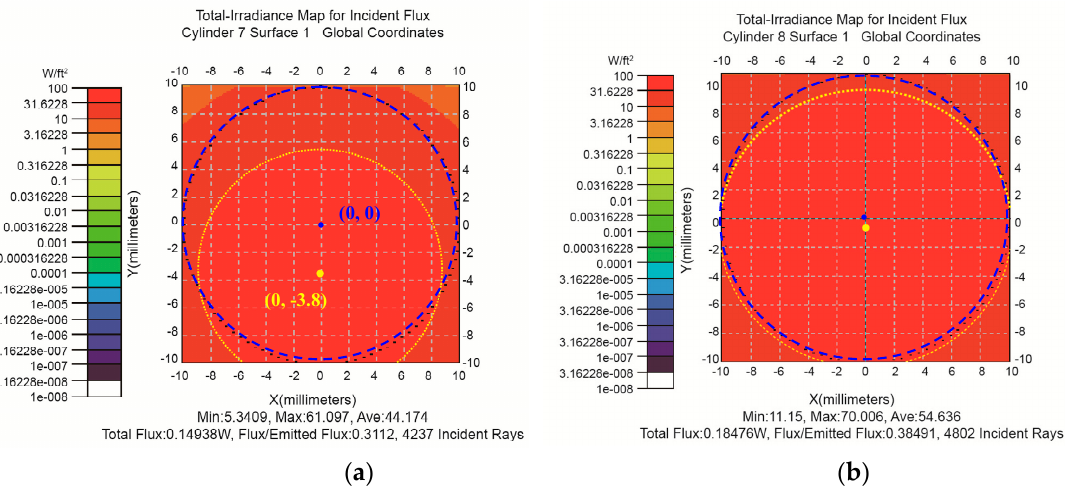
Figure 6. Luminous fluxes distribution corresponding to the case that the optical axis of Fresnel lens was at the center of implantable photovoltaic cell ( a ); and was shifted 0.50 cm of the implantable photovoltaic cell ( b ) at the times of 12:00.